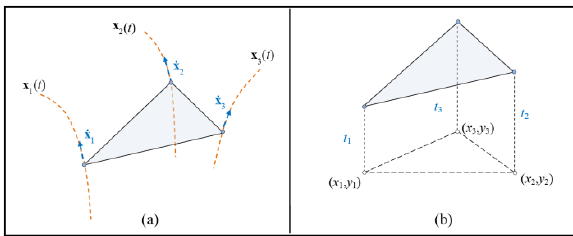
Figure 4. a) a general time dependent triangle surface model, b) an explicit triangle surface model